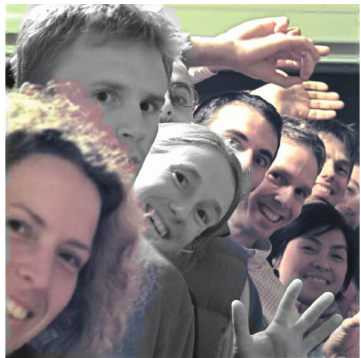
Figure 17: Depth-based color manipulation of all-in-focus